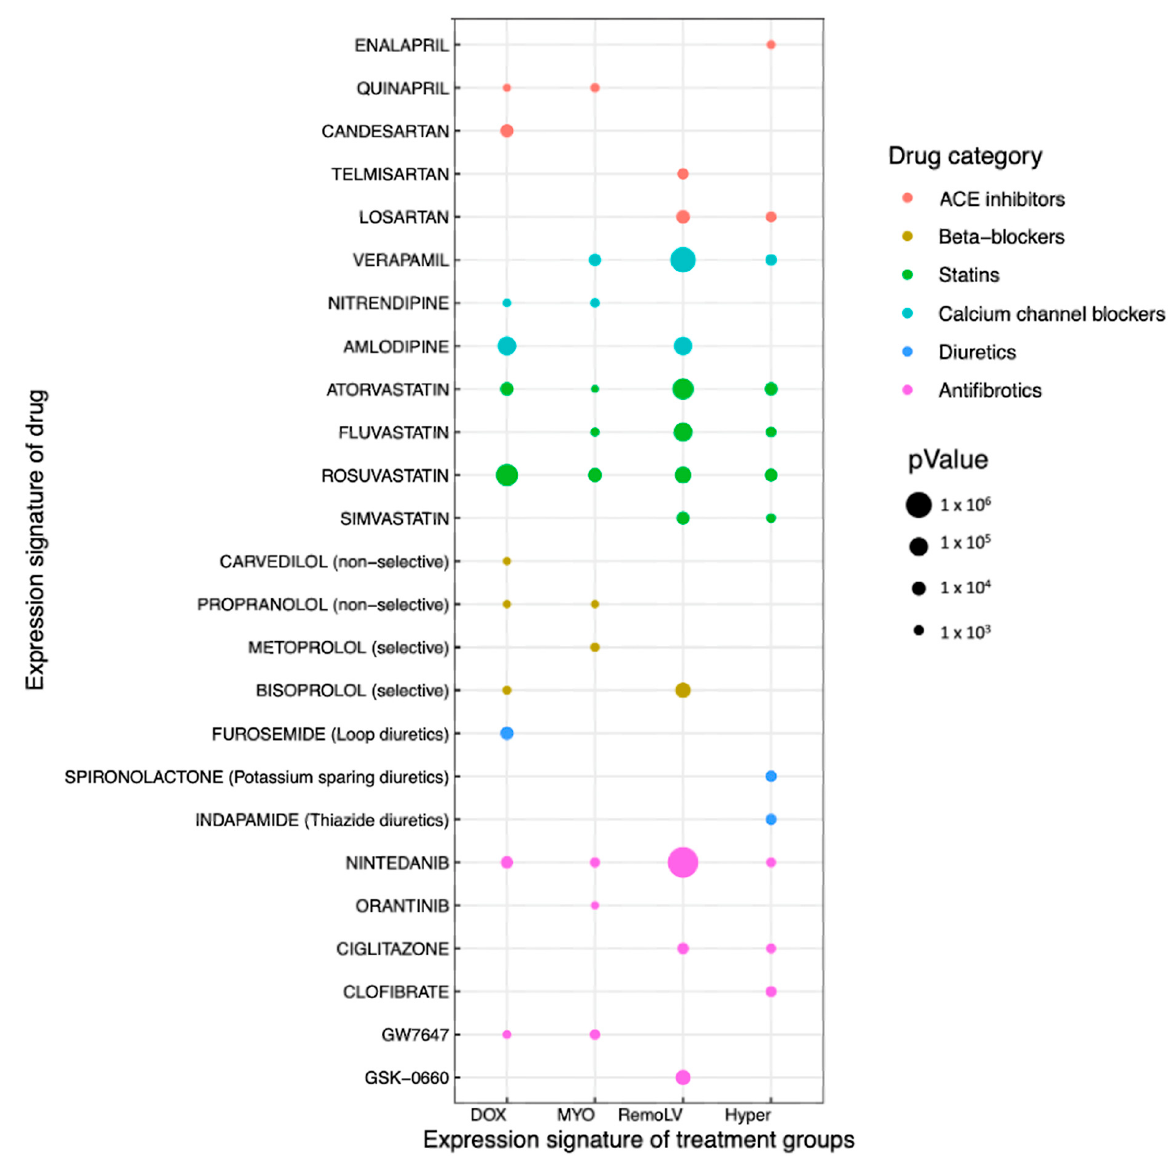
Figure 5. Drug prediction based on the gene expression signature datasets. Bubble plot lists of selected significant chemical perturbagens (predicted drugs) based on the gene expression signature datasets of DOX (N = 5), MYO (N = 5), RemoLV (N = 3) and Hyper (N = 3) groups. Selected perturbagens reflect (Pearson’s correlation coefficient) the gene expression signatures of MF models. The size of the dot represents p -value. ARB, angiotensin II receptor blocker; ACE, angiotensin converting enzyme.